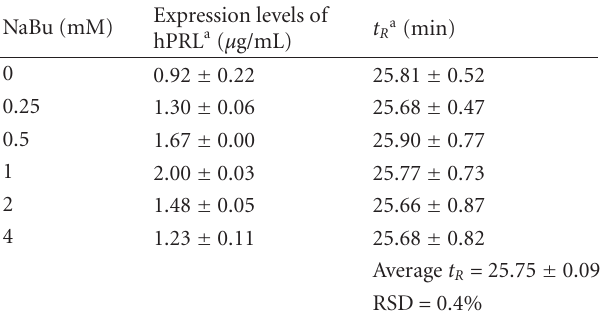
Table 1: Expression levels and RP-HPLC retention times ( t R ) of hPRL obtained from CHO cells treated with di ff erent concentra- tions of NaBu for 10 days. The t R were compared with those of the Internal Reference Preparation of periplasmic E. coli -derived hPRL ( t R : 26 . 00 ± 0 . 72 minutes). NaBu